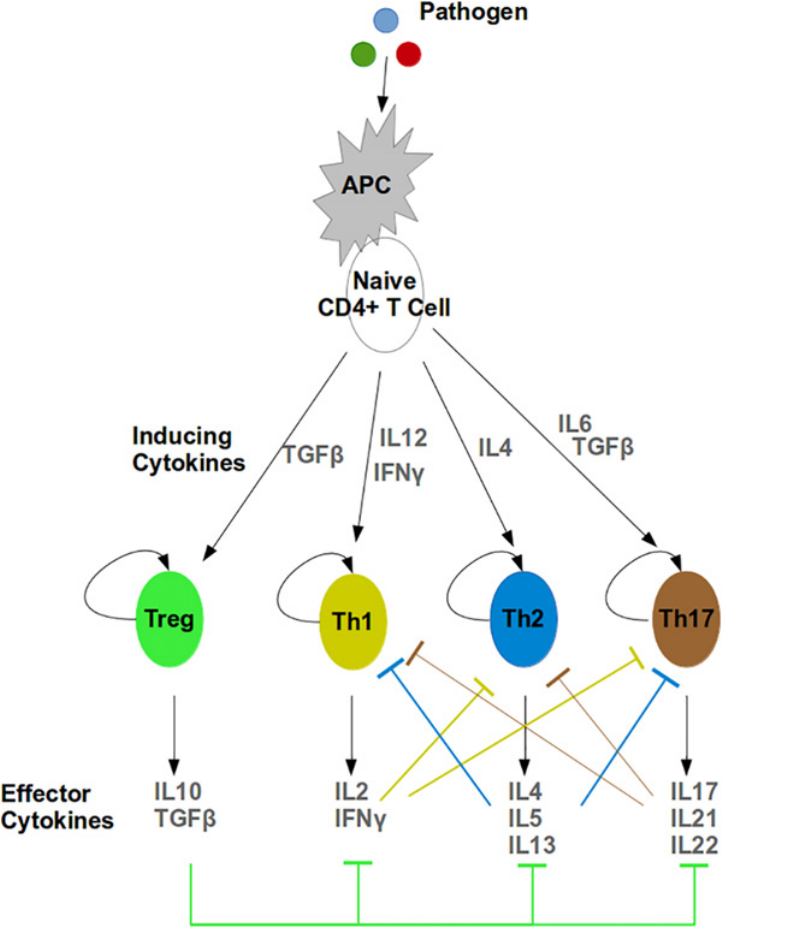
Fig 2. CD4+ T Cell differentiation as modeled for classroom